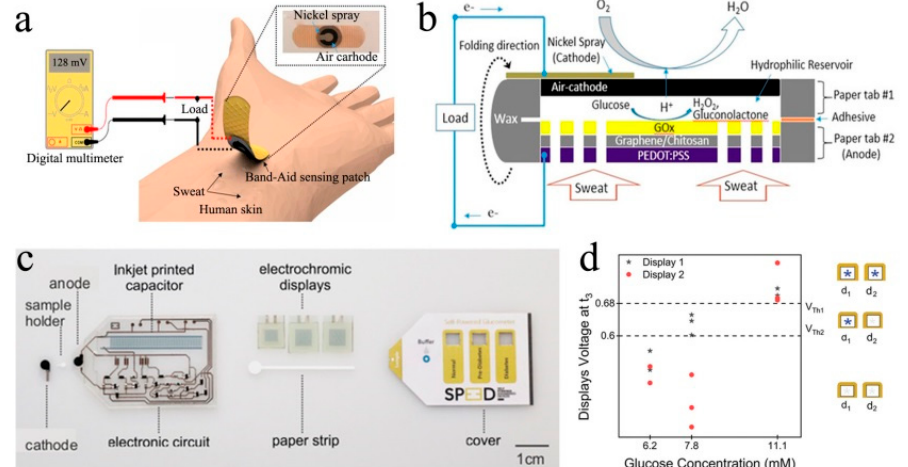
Figure 2. ( a ) Schematic diagram and ( b ) the sectional view of the paper-based EBFC-SPB for sweat glucose sensing on skin [54].( c ) The structure of the self-powered glucometer and ( d ) the voltage change of this sensor in the presence of 6.2 mM, 7.8 mM, and 11.1 mM glucose [36]. Copyright 2021 John Wiley and Sons.